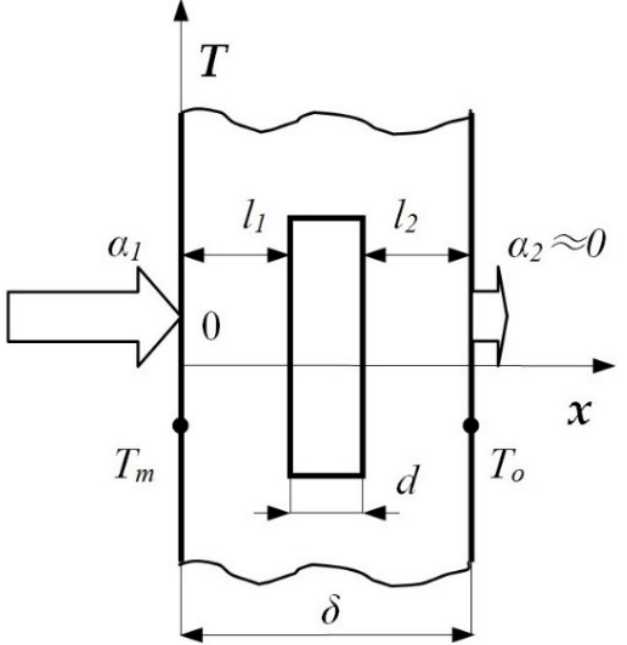
Figure 2. Example of using the method of temperature forcing at the plate edge to locate a defect inside the plate—Formula (8).